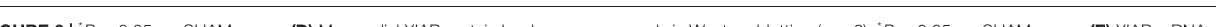
FIGURE 6 | * P < 0.05 vs. SHAM group. (D) Myocardial XIAP protein levels were assessed via Western blotting ( n = 3), * P < 0.05 vs. SHAM group. (E) XIAP mRNA level was negatively correlated with miR-186-5p level in heart tissue. (F) XIAP mRNA level was positively correlated with TUG1 level in heart tissue. (G) XIAP was silenced or overexpressed with AAV-shXIAP or AAV-pcDNA3.1-XIAP. qRT-PCR was used to detect the transfection efficiency ( n = 3). (H) The expression levels of miR-186-5p were tested in XIAP-down regulated or XIAP-overexpressed rats with qRT-PCR ( n = 10). (I) The expression levels of XIAP mRNA were tested in miR-186-5p-downregulated or miR-186-5p-overexpressed rats with qRT-PCR ( n = 10). (J) Pulldown assay was conducted to prove the combination between miR-186-5p and XIAP mRNA. (K) Overexpression of XIAP improved cardiac function. LVEF was assayed by echocardiography ( n = 10). (L) HBFP staining was used to measure microinfarct size ( × 200; scale bar = 50 µ m) ( n = 10). (M) cTnI parameters for rats in each group ( n = 10). (N) Western blotting was used to quantify myocardial NLRP3, ASC, caspase-1 p20, GSDMD, IL-1 β , and IL-18 protein levels, with GAPDH as a normalization control ( n = 3). Data are mean ± SEM from three or more independent experiments. * P < 0.05, ** P < 0.01, *** P <